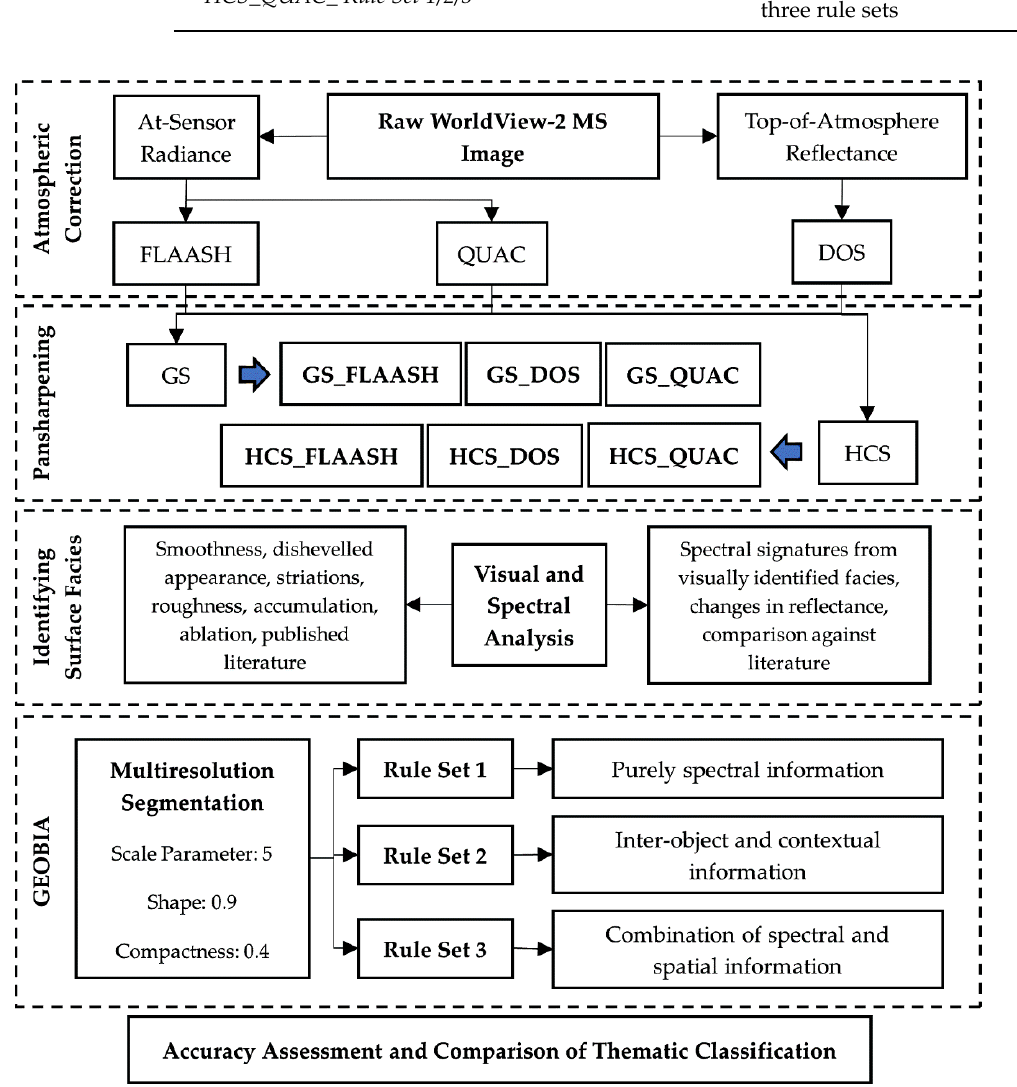
Figure 2. Methodology of the proposed study. MS: multispectral image; FLAASH: Fast Line-of-Sight Atmospheric Analysis of Hypercubes; QUAC: Quick Atmospheric Correction; DOS: Dark Object Subtraction; GS: Gram – Schmidt; HCS: Hyperspherical Color Sharpening; GEOBIA: Geographic Ob- ject-Based Image Analysis. The blue arrows from GS and HCS highlight the individual image sub- sets post